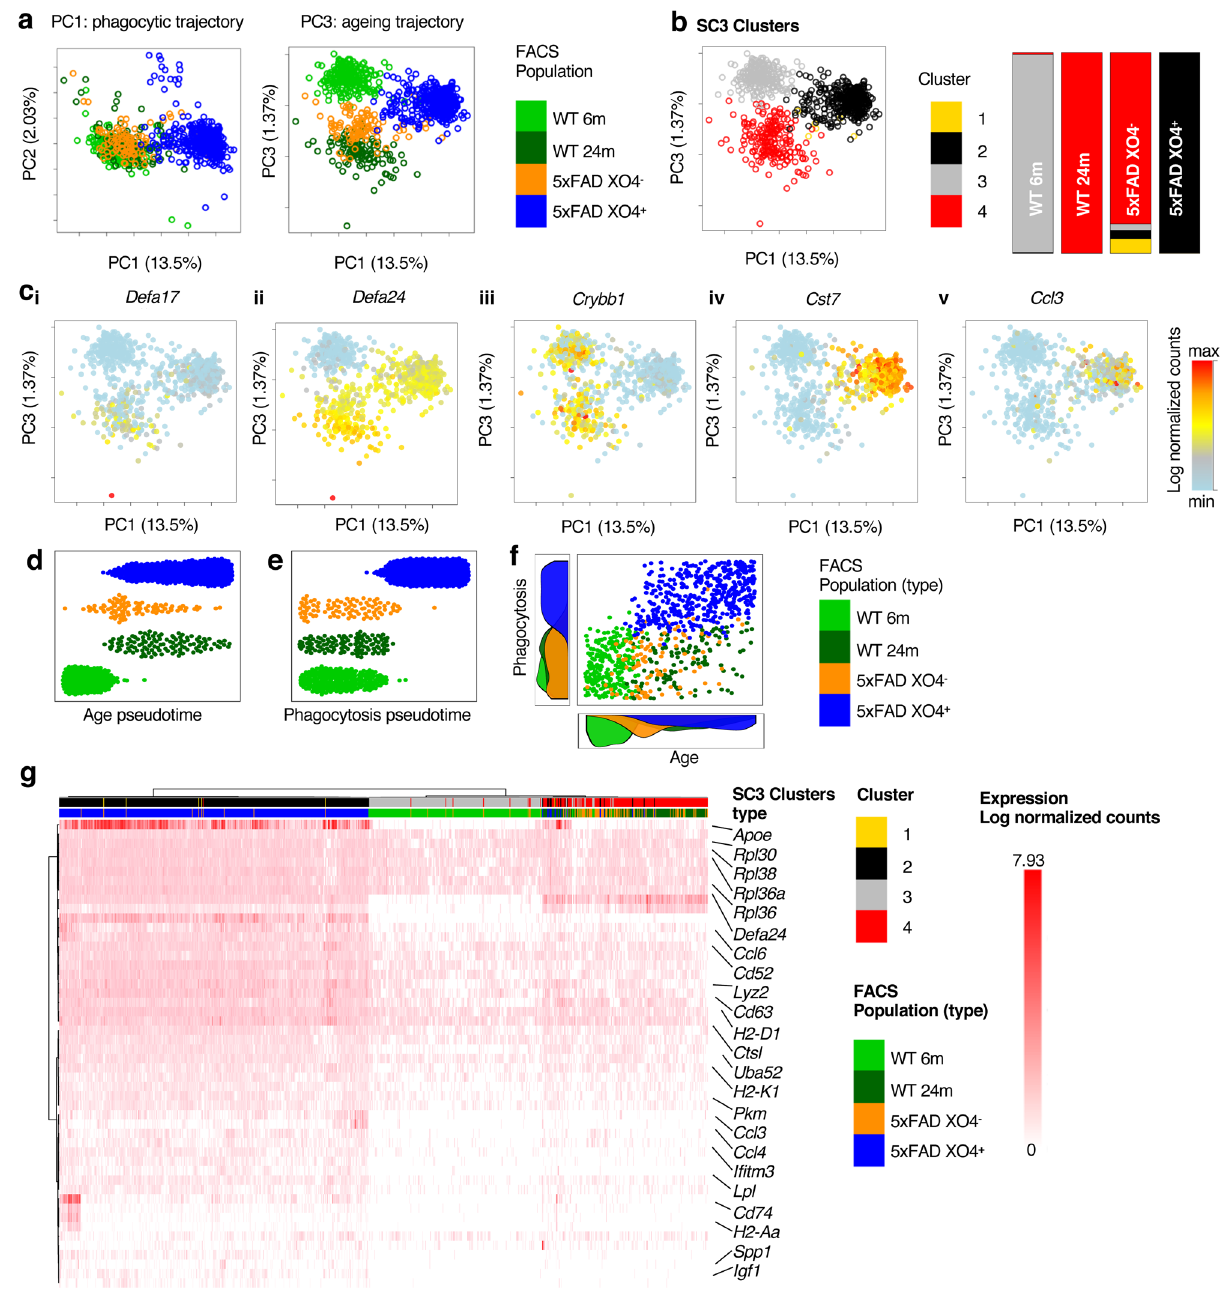
Fig. 2 Single-cell sequencing identi fi es an ageing pro fi le in 5xFAD XO4 − microglia. a PCA of 893 single cells (6 m WT = 243 cells, 24 m WT = 121 cells, 6 m 5xFAD XO4 − = 95 cells, 6 m 5xFAD XO4 + = 434 cells; m, month) and 1671 feature genes showing the distribution of cells from each FACS-sorted sample. PC, principal component. b PCA plot of single microglia coloured by single cell consensus (SC3) clusters and composition of automated clusters as a percentage of sequenced FACS-sorted cell populations. c PCA plots for single microglia coloured by expression of selected ageing microglia genes (i-ii), homeostatic (iii) and signature genes associated with XO4 + microglia (iv-v). min = 0 for all genes, Defa17 max = 4.77 , Defa24 max = 7.41 , Crybb1 max = 4.13 , Cst7 max = 5.47 , Ccl3 max = 4.89. d , e Diffusion maps pseudotime analysis of microglial populations ordered by their expression of ( d ) ageing DEGs (24 m WT vs 6 m WT, 42 DEGs) or ( e ) phagocytic DEGs (6 m 5xFAD XO4 + vs 6 m 5xFAD XO4 − , 474 DEGs). f Scatter plot showing the relationship between ageing and phagocytosing pseudotime in individual cells, and the density of cells at each point during the ageing (bottom) and phagocytosing (left) trajectories. g Hierarchical clustering and heatmap showing expression of the top 50 DEGs across the 4 SC3 dysregulated in XO4 − as compared with WT cells (Supplementary Fig. 8d, e). This suggests that XO4 − microglia are on an independent trajectory and are not necessary cellular intermediates poised to become XO4 + cells.